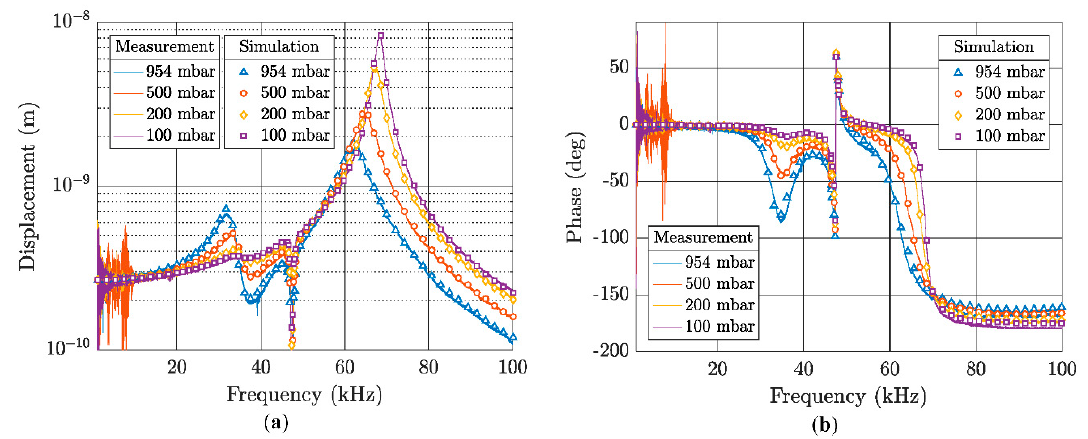
Figure 3. Comparison of the measured and the simulated frequency response of the displacement of the membrane for different ambient pressure values. These results refer to the full-system simulation of the electrically actuated transducer. ( a ) Magnitude of the displacement of the membrane; ( b ) Phase shift between the oscillating input voltage and the displacement of the